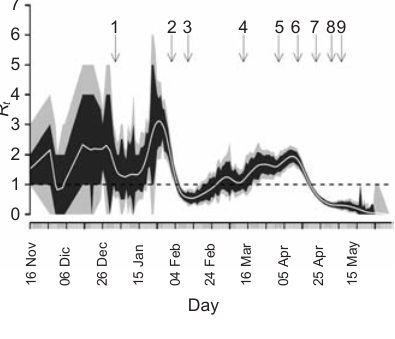
Figure 3. Estimated effective reproduction number ( R t ) (number of secondary infec- tions generated per primary case) during the SARS epidemic in China. Values repre- sent average R t (central white line) and associated 95% (grey) and 80% (black) confidence intervals, by date of symptom onset. The critical value of R t =1, below which sustained transmission is impossi- ble, is marked with a broken horizontal line. Arrows reflect the moment of impor- tant events and public health control